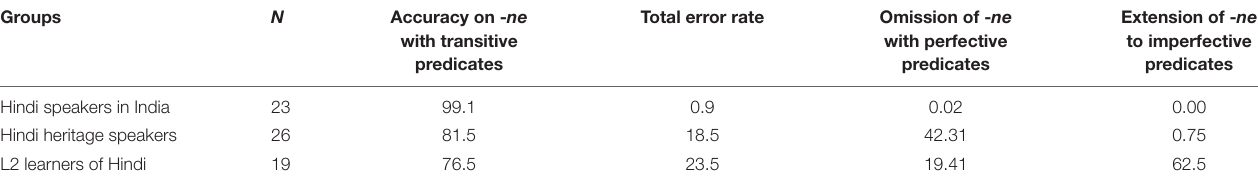
TABLE 4 | Elicited Production Task. Groups